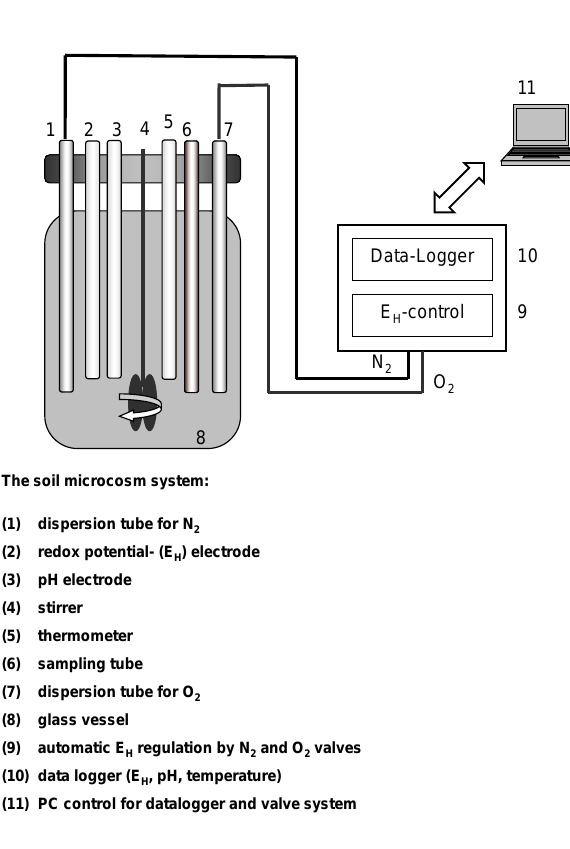
Fig. 2. Biogeochemical microcosm